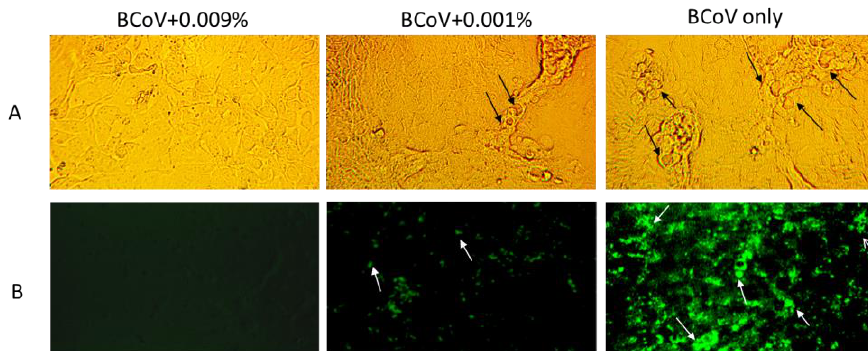
Figure 2. Bright light images and direct immunofluorescence staining of BCoV infected cells in the presence and absence of 222B. A : Hrt18G cells infected with ~1 × 10 6 TCID 50 of BCoV per well in a 12-well plate. The concentration of 222B is labeled above the images in the BCoV infection. The bright light images were captured at 72hpi at 20 × magnification. Black arrows indicate vesicles within the virus-infected cells. B : Hrt18G cells at 72hpi were stained with 1:40 diluted BCoV antibody conjugated with FITC and viewed under the fluorescence microscope. Fluorescent images were captured at 10 × magnification. White arrows indicate FITC stained BCoV antigens within the infected cells.